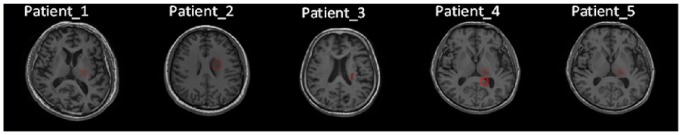
Illustration of lesion location in red for each patient.